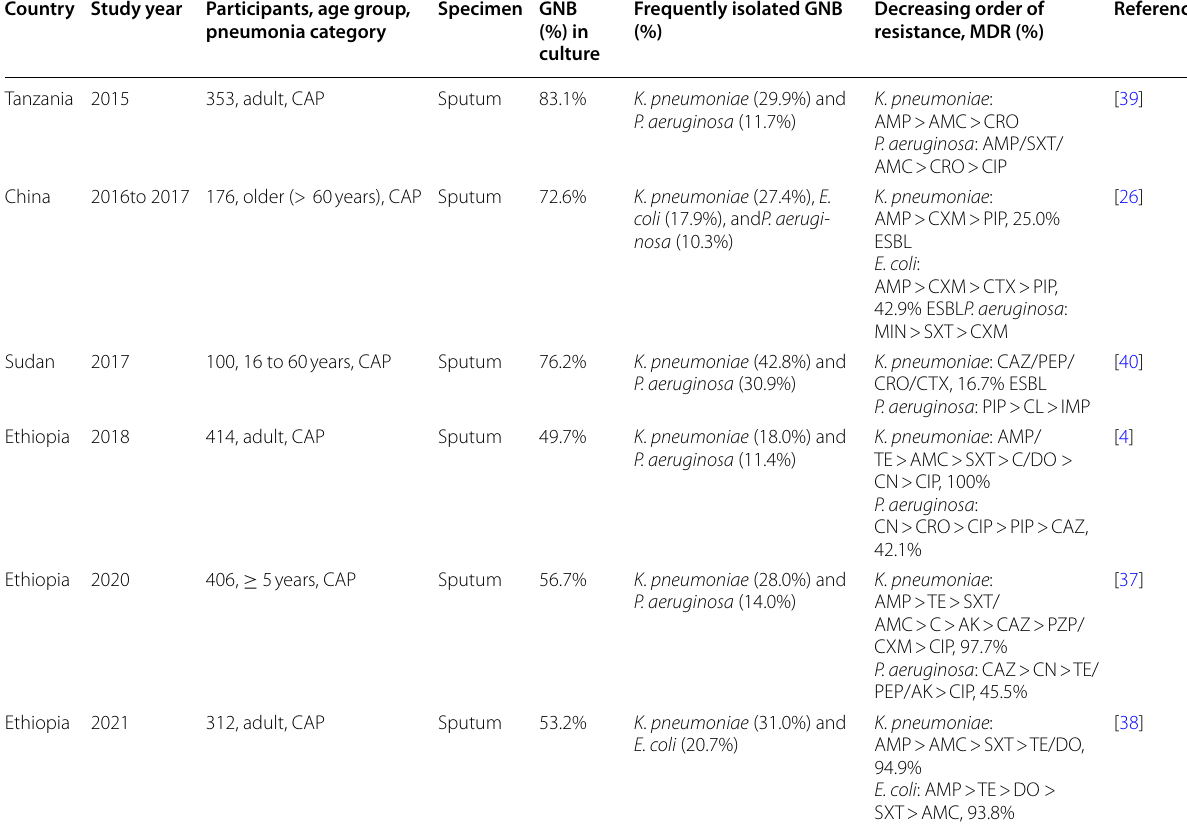
Table 1 Summary of the isolation and drug resistance profile of GNB in CAP Country Study year Participants, age group, pneumonia